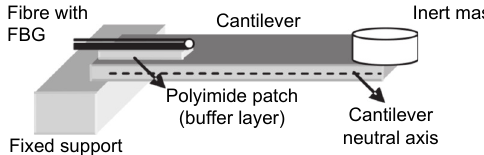
Fig. 15 | An FBG based accelerometer with an additional buffer layer. Figure reproduced with permission from ref. 75 , Elsevier.